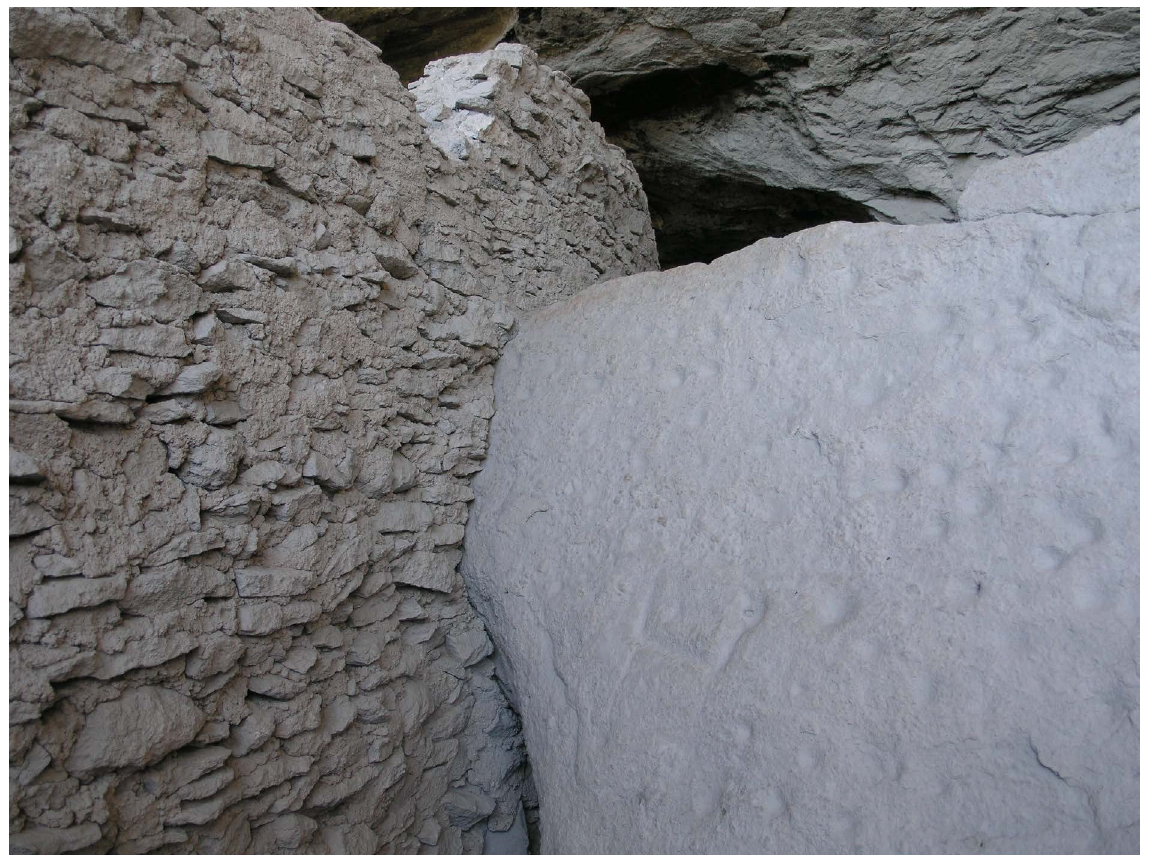
Figure 4. Exterior of the northeast wall of room 27 built over the west end of a vertical cupule panel on the south side of RMP-4. The cupule panel is a little more than 2 m in